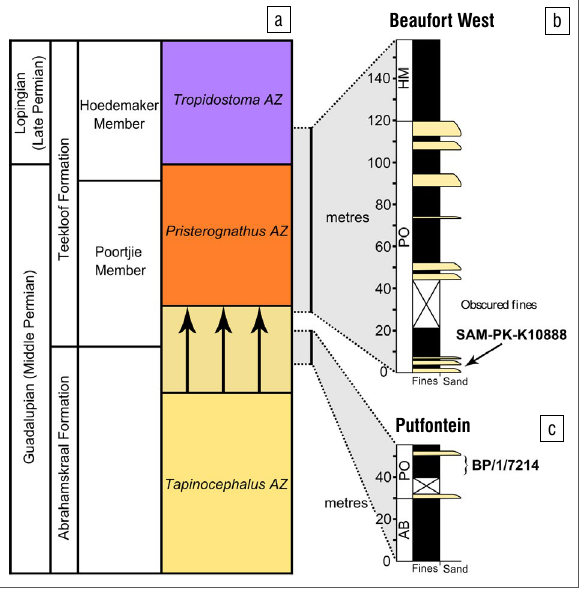
Figure 2: (a) Extension of the Tapinocephalus Assemblage Zone (AZ) into the lower Teekloof Formation. Former extent of biozones after Smith et al. 17 Approximate position of the Guadalupian– Lopingian boundary after Rubidge et al. 22 Arrows indicate the extension of Tapinocephalus AZ into the Teekloof Formation. (b) Stratigraphic section measured at Beaufort West between the level of the SAM-PK-K10888 locality and the lower Hoedemaker Member. (c) Stratigraphic section on the farm